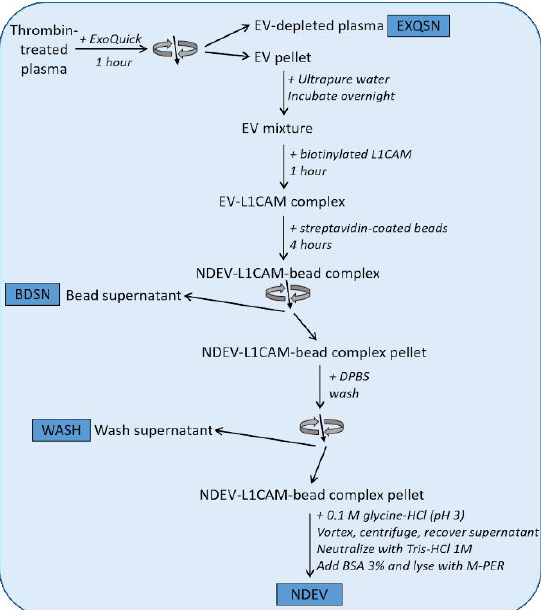
Figure 1. Experimental workflow for exosome validation studies. Thrombin-treated plasma was first processed with ExoQuick polymer reagent, whereafter the EV-depleted plasma (EXQSN) was collected. The EV pellets were then mixed with L1CAM biotinylated antibody, then streptavidin- coated beads. The bead supernatant (BDSN) was collected for biomarker analyses and the bead complex was next washed with Dulbecco’s Phosphate Buffered Saline (DPBS) (WASH was collected). Neuron-derived small extracellular vesicles (NDEVs) were then recovered from the mix. Exosome-related proteins and neuron-specific proteins were measured at each step of the isolation procedure. The results from these validation studies are presented in Figures 2 and 3.